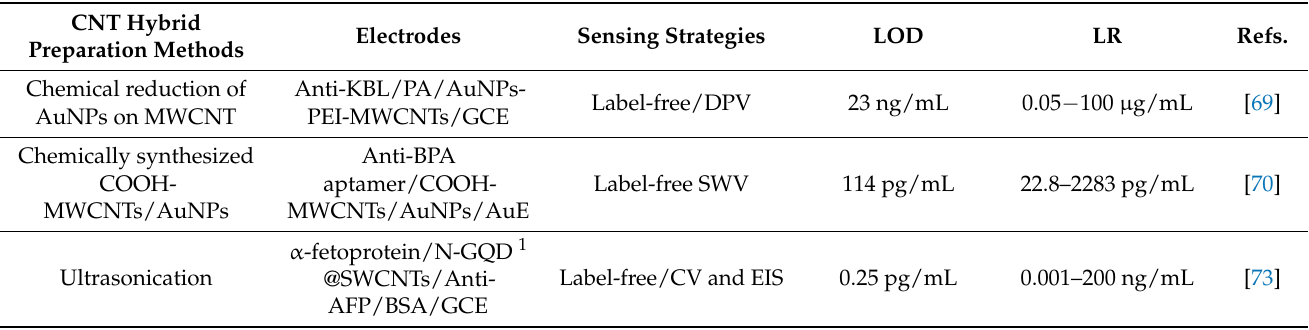
Table 2. Preparation of CNT-based nanocomposites for immunosensor fabrication and their sensing properties.